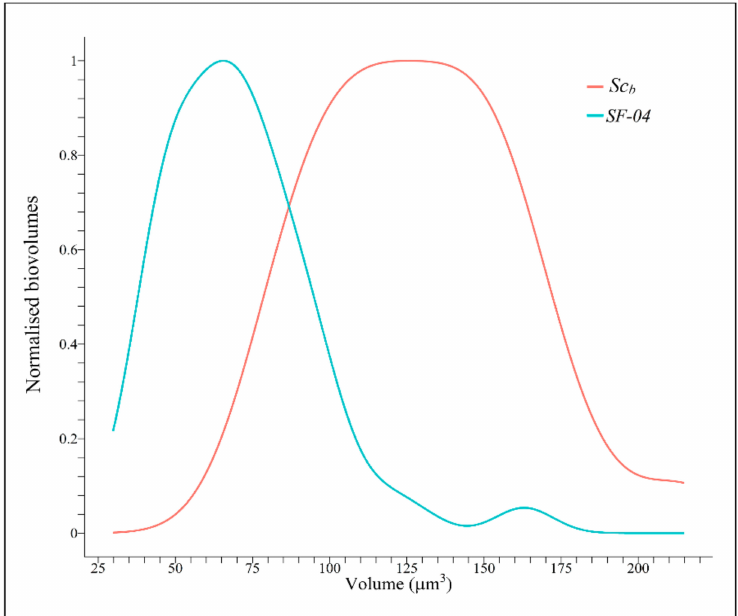
Figure 5. Normalised cell volume (biovolume) distribution values estimated for the Saccharomyces cerevisiae var. boulardii ( S Cb ) and Saccharomyces cerevisiae (SF-04)